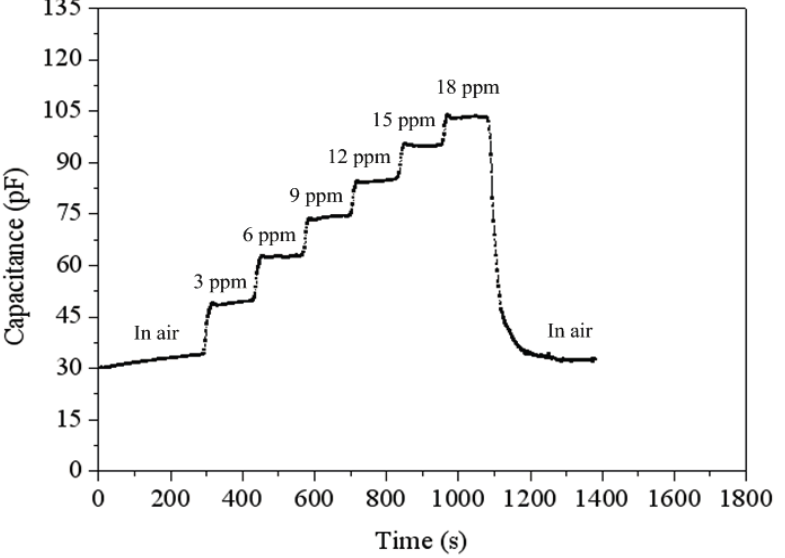
Figure 10. Test of the ethanol